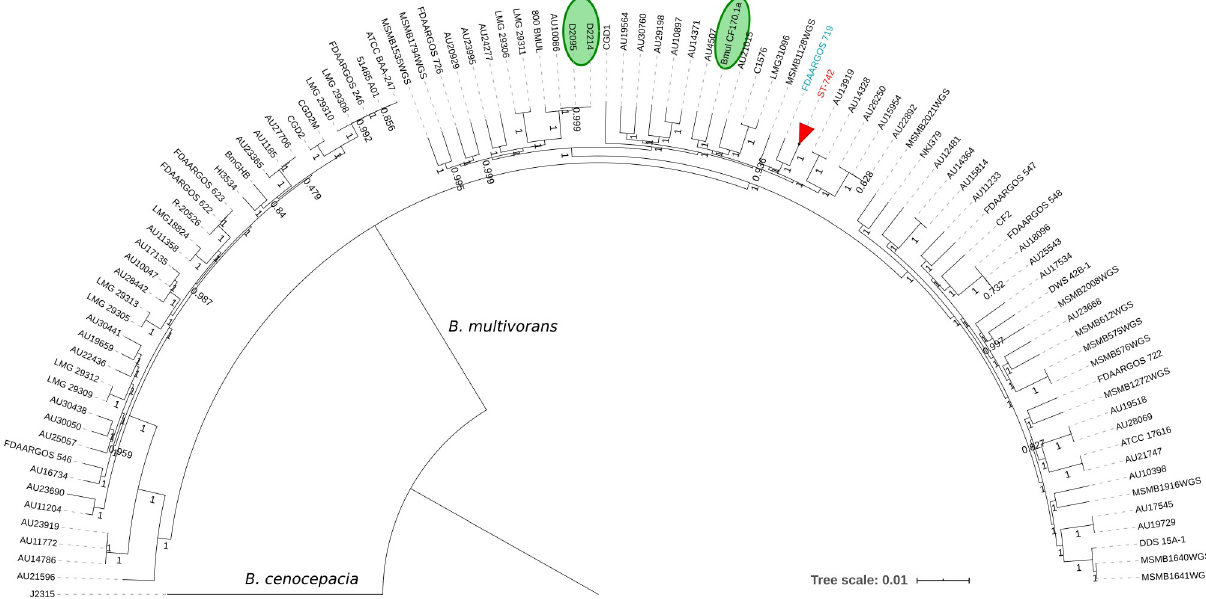
Fig 3. Population structure of Burkholderia multivorans . We established the population structure via the isolation of core genes across all publicly available B . multivorans genomes in order to position our cluster of isolates in the population. We collapsed the subtree (highlighted in red) consisting of our thirteen ST-742 isolates as they showed to be clonal within the population. B . cenocepacia J2315 was used as outgroup. The strains highlighted in green are from the study by Silva et al. (2016) and Caballero et al. (2018), D2095 with D2214 and Bmul_CF170.1a respectively.